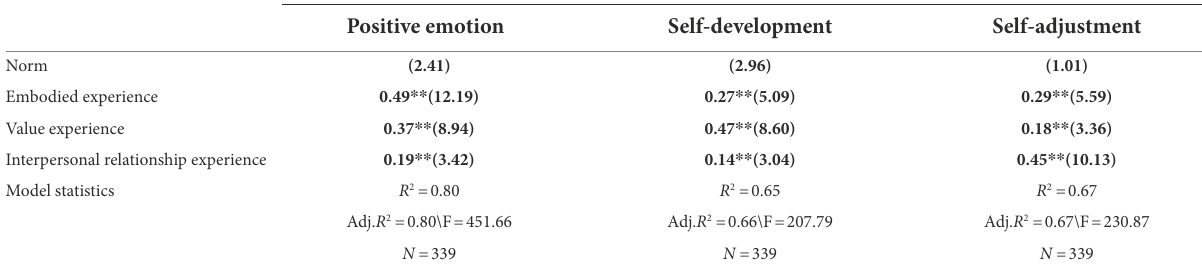
TABLE 7 Linear regression